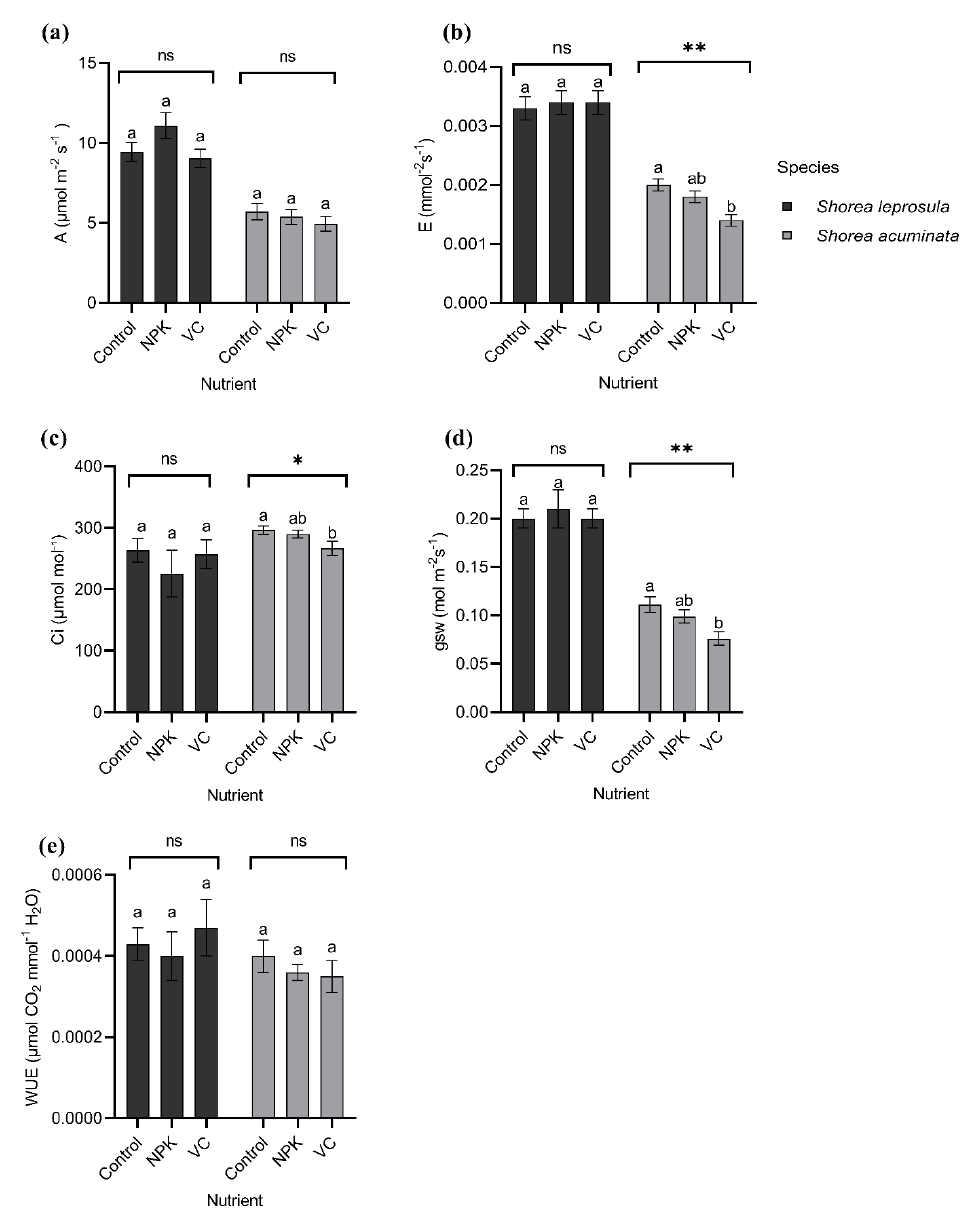
Figure 7. Shorea leprosula Miq. and Shorea acuminata Dyer gas exchange characteristics in different light irradiances (Mean ± SE); ( a ) photosynthesis rate (A, µ mol m − 2 s − 1 ); ( b ) transpiration rate (E, mmol − 2 s − 1 ); ( c ) intercellular carbon concentration (Ci, µ mol mol − 1 ); ( d ) stomatal conductance (g sw , mol m − 2 s − 1 ); ( e ) and water-use efficiency (WUE, µ mol CO 2 mmol − 1 H 2 O). Alphabets denote significant differences between light irradiance treatments with *, and ** indicating significant at p < 0.05, and p < 0.01, respectively; ns =